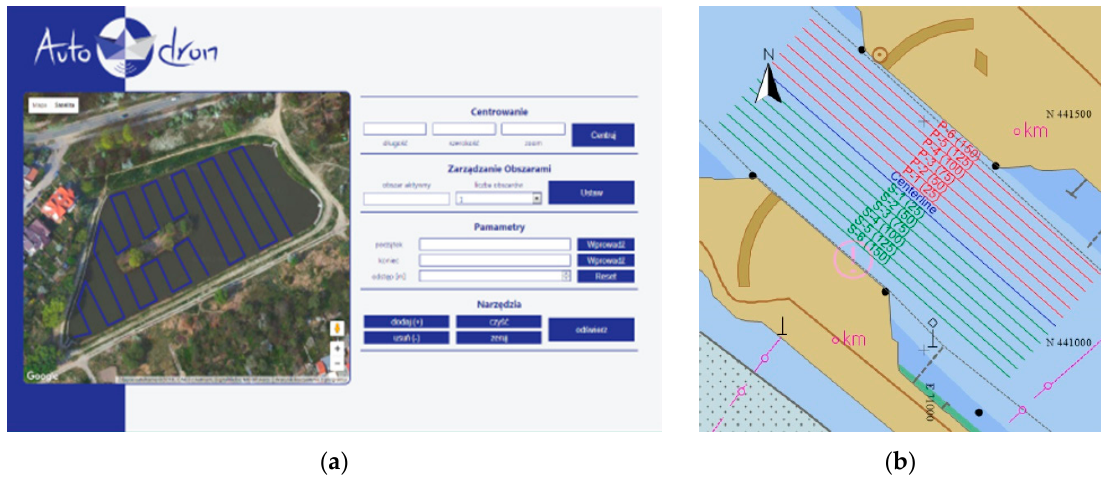
Figure 5. Applications used to plan hydrographic survey, such as AutoDron ( a ) [19] and QINSy ( b ).